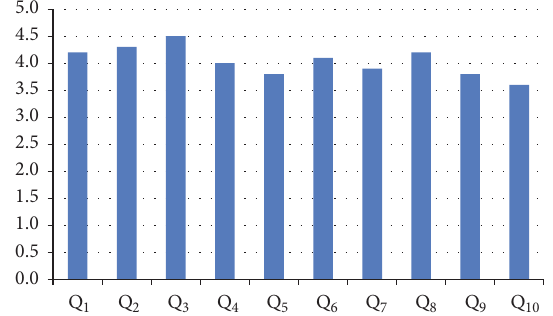
Figure 27: The average score of statements in Table 7 answered by participants to measure usability.